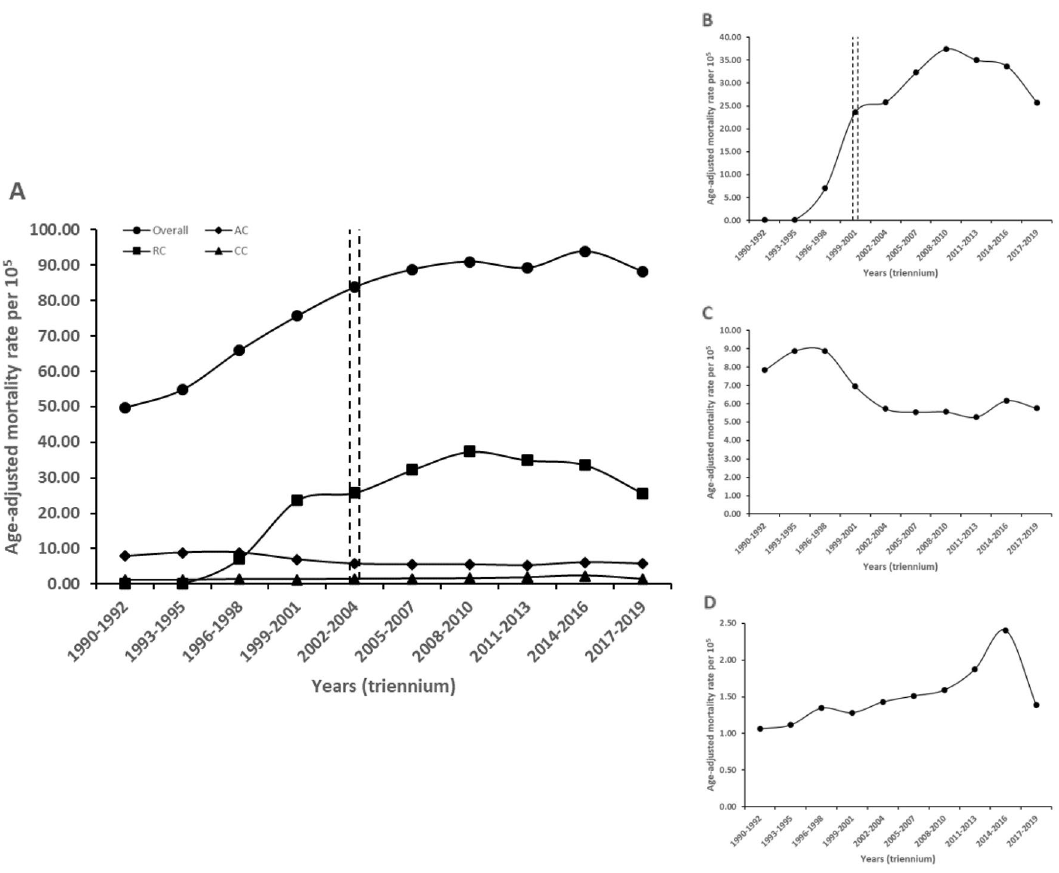
Figure 1. Trends in age-adjusted mortality rates for diabetes mellitus and for specific complications recorded as primary cause in Mexico, 1990–2019. This figure shows age-adjusted DM mortality rate for specific complications registered as a primary cause of death in Mexico from 1990 to 2019, with respect to the national rate ( A ). Likewise, a smaller range of the Y-axis shows the age-adjusted mortality rate for DM deaths that registered renal complications ( B ), acute complications ( C ) and circulatory complications ( D ) as a primary cause of death. Data markers represent observed rates by triennium. Lines are fitted rates by triennium based on joinpoint analysis. DM diabetes mellitus, AC acute complications, RC renal complications, CC circulatory complications. a Age-adjusted mortality rates are shown per 100,000 population. b The dotted lines indicates the inflection point in the